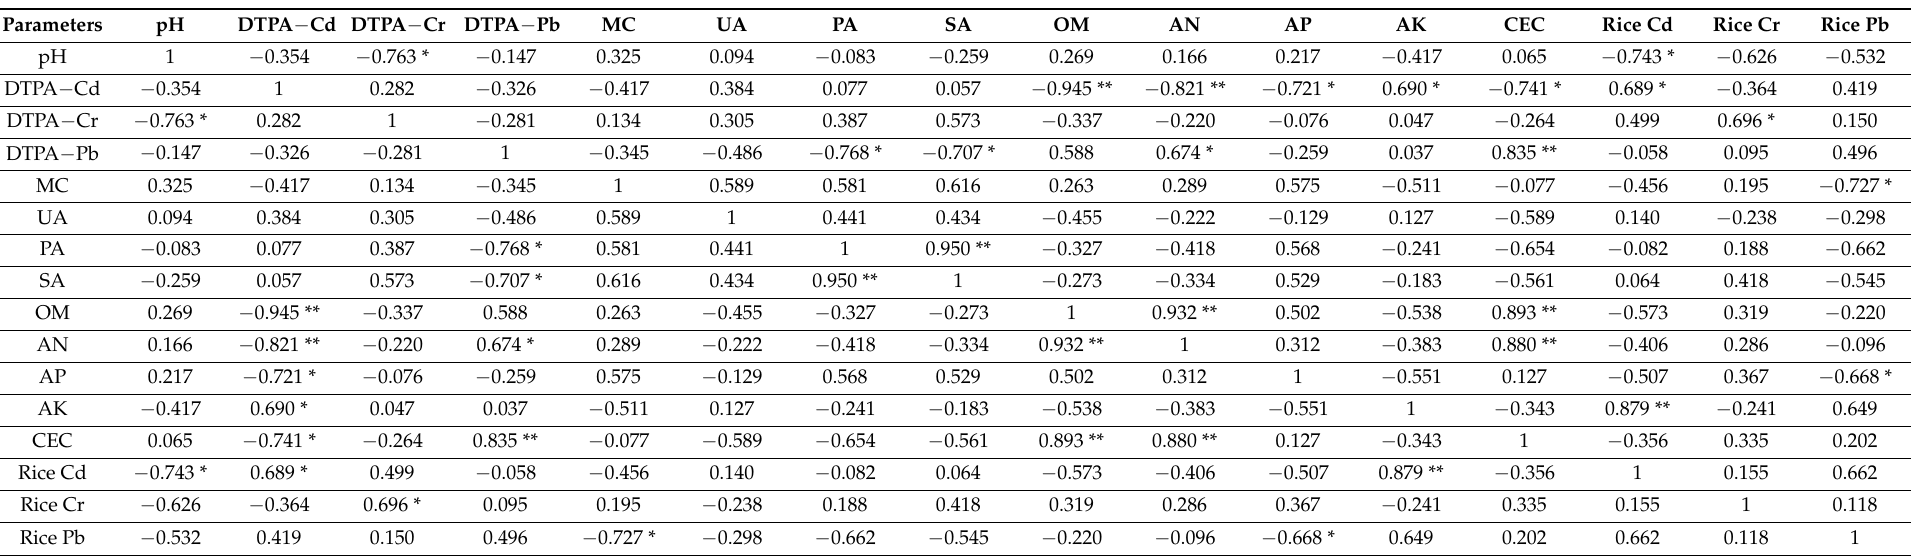
Table 2. Correlation coefficient of soil physicochemical parameters and Cd, Cr, and Pb in